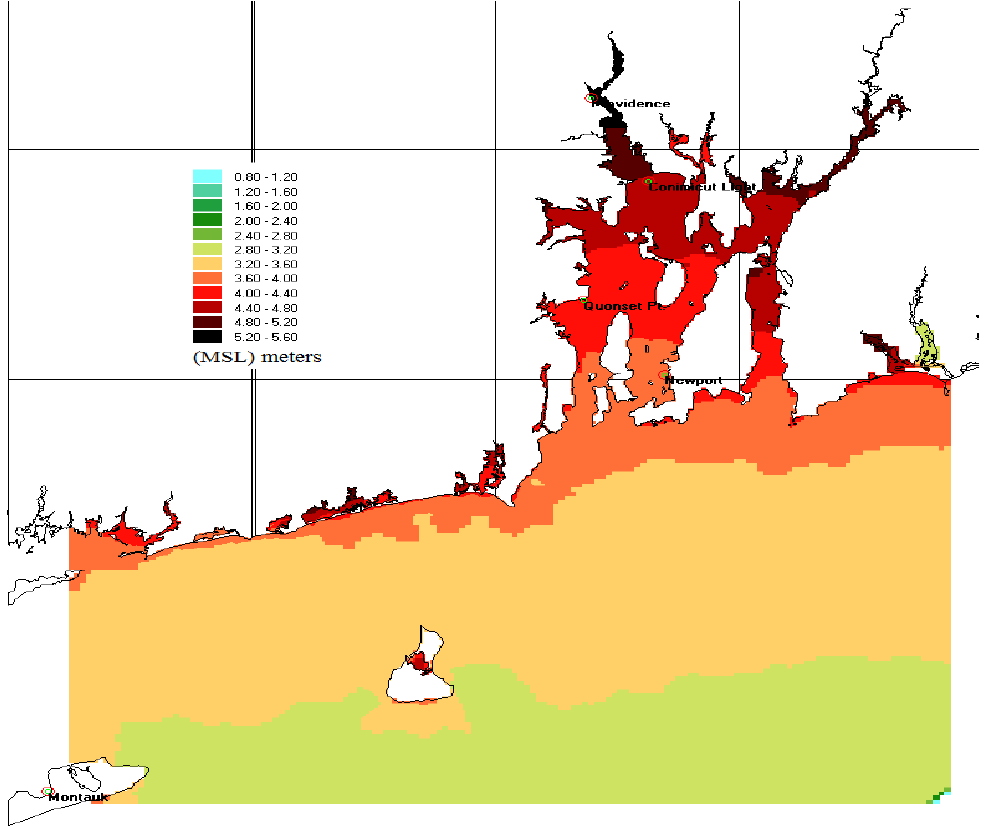
Figure 4. Water level contour map for 100 year, upper 95%, surge plus tide case, based on NACCS data.